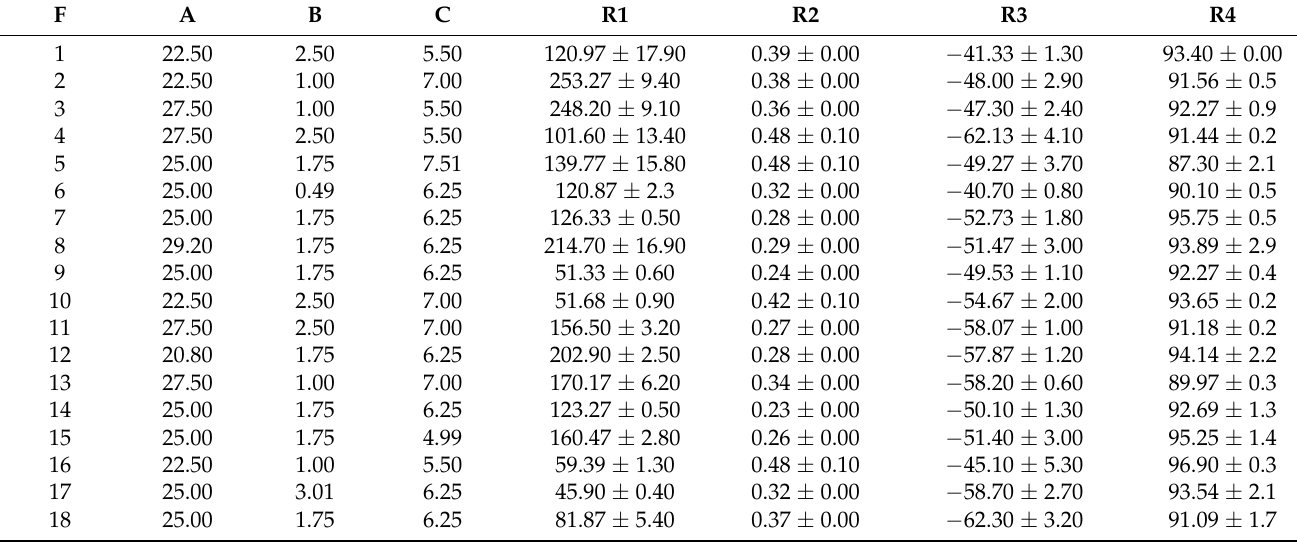
Table 4. Optimization study formulations of VLT-ETH formulations and the observed